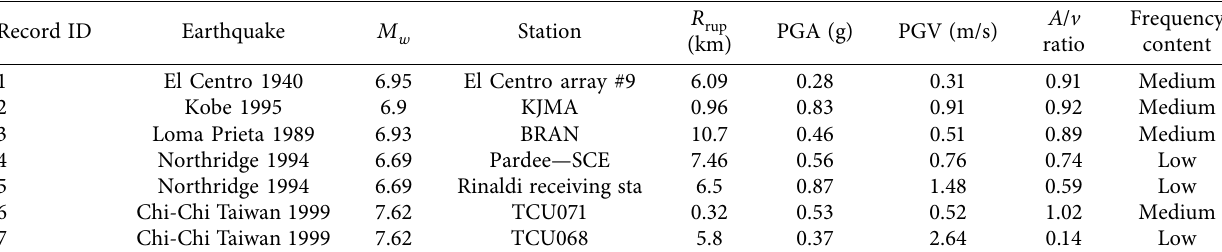
Figure 10: Plastic deformation distribution over the height of the frame structures at two diferent roof drift ratios. (a) Reference frame “PF4.” (b) Reference frame Table 2: Characteristics of the selected ground motions.